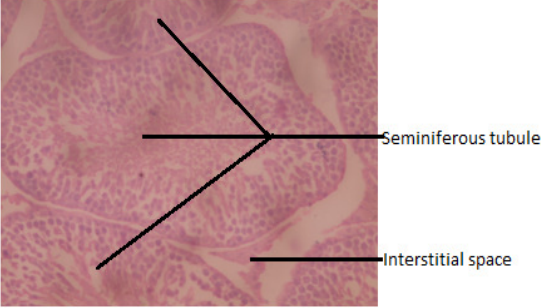
Fig. 4. Photomicrograph of transverse section of typical testicular tissue from group 4 rats (x400 magnification; H&E) Slide show essentially normal testicular tissue containing spermatogenic cells and mature